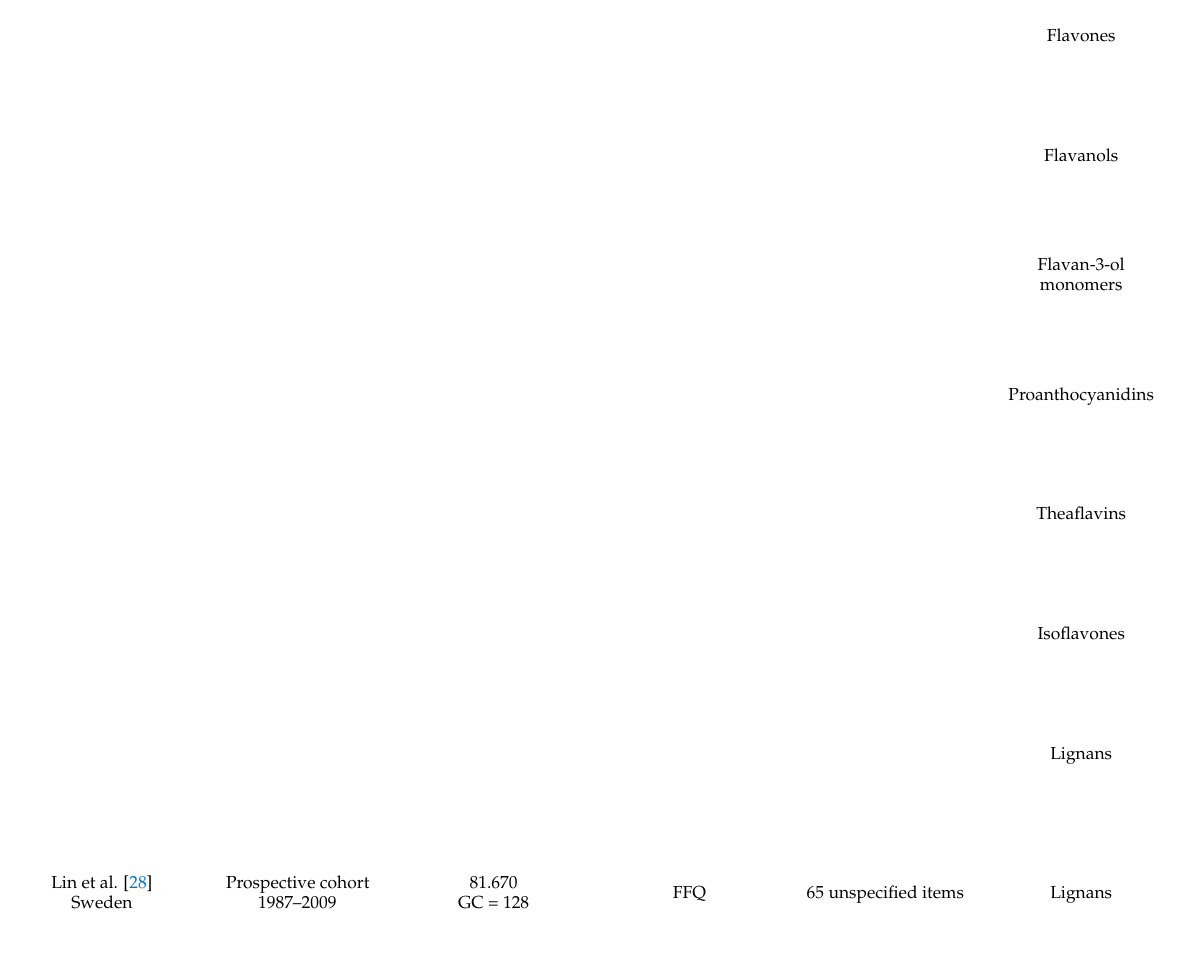
Model 2: Model 1 + education, BMI, alcohol intake, smoking status, gastric ulcer, duodenal ulcer, and diabetes. P.S: For men only, adjustment for sex was not